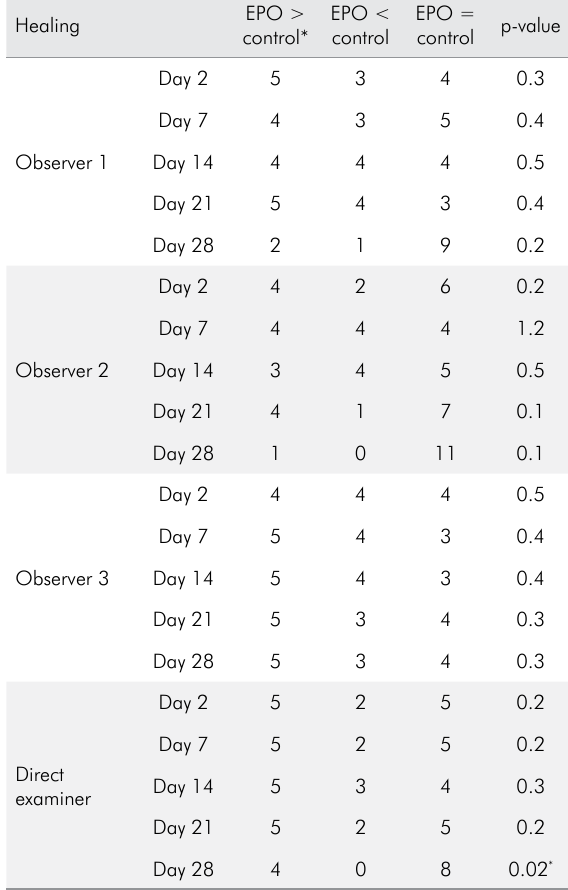
Table 2. Comparison of healing rate based on photography and direct examination